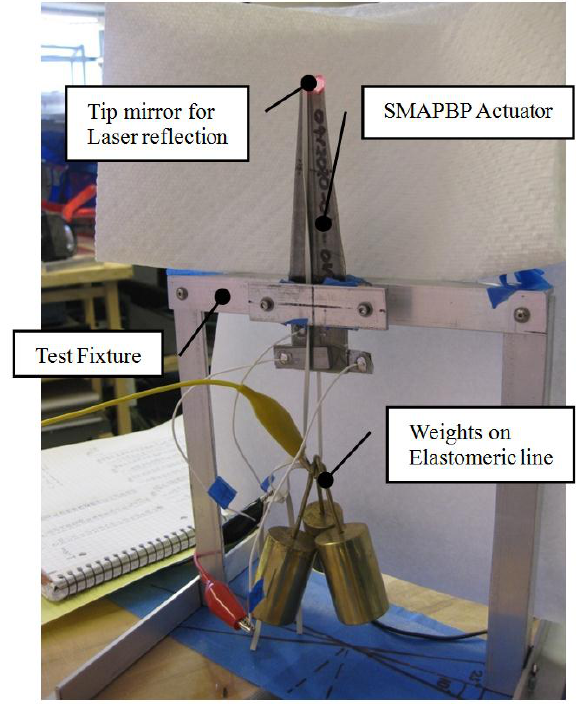
Figure 2. SMAPBP actuator clamped in test fixture to measure tip